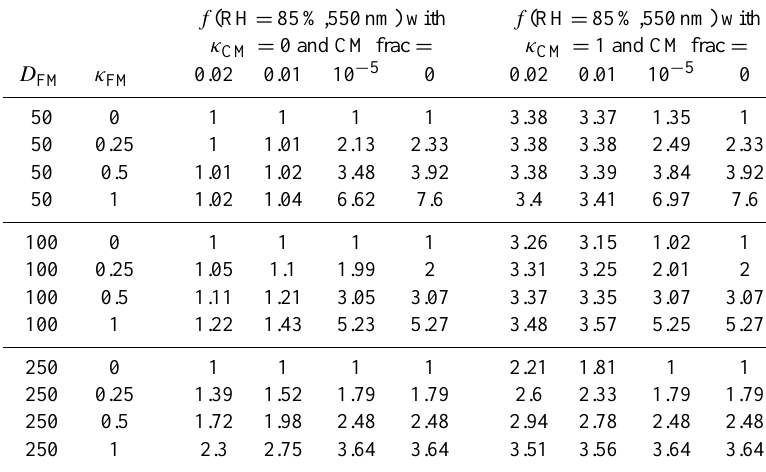
Table 3. The scattering enhancement f (RH) at RH = 85% and λ = 550nm modeled for different fine mode diameters ( D FM ) and fine mode hygroscopicities ( κ FM ). The coarse mode was assumed to consist of non-hygroscopic material ( κ CM = 0, e.g., dust, middle column) or of very hygroscopic material ( κ CM = 1, e.g., sea salt, right column). CM frac denotes the coarse mode number fraction. The refractive index was assumed to be constant with m = 1 . 54. See text for more